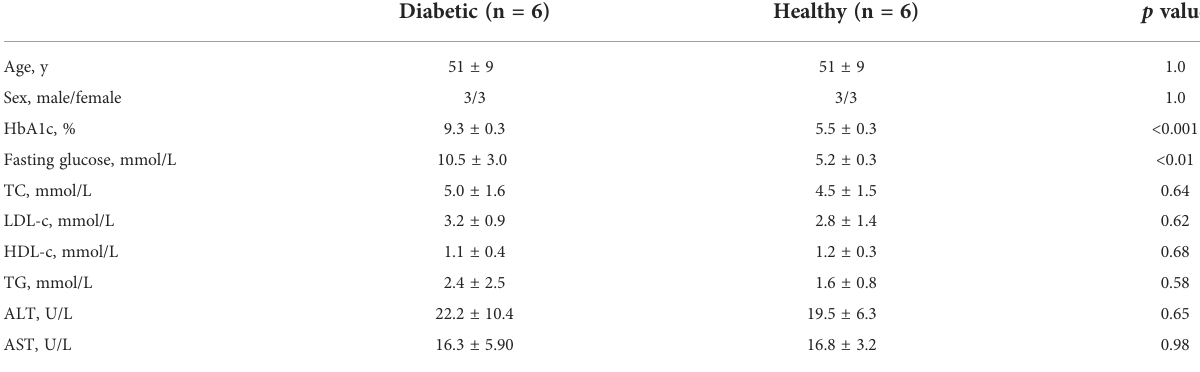
TABLE 2 Clinical and laboratory characteristics of diabetic patients and non-diabetic healthy controls in Study 2.